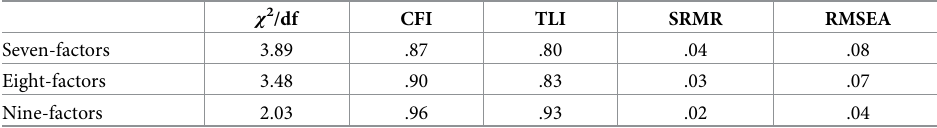
Table 4. Fit indices for the EFAs with seven, eight, and nine